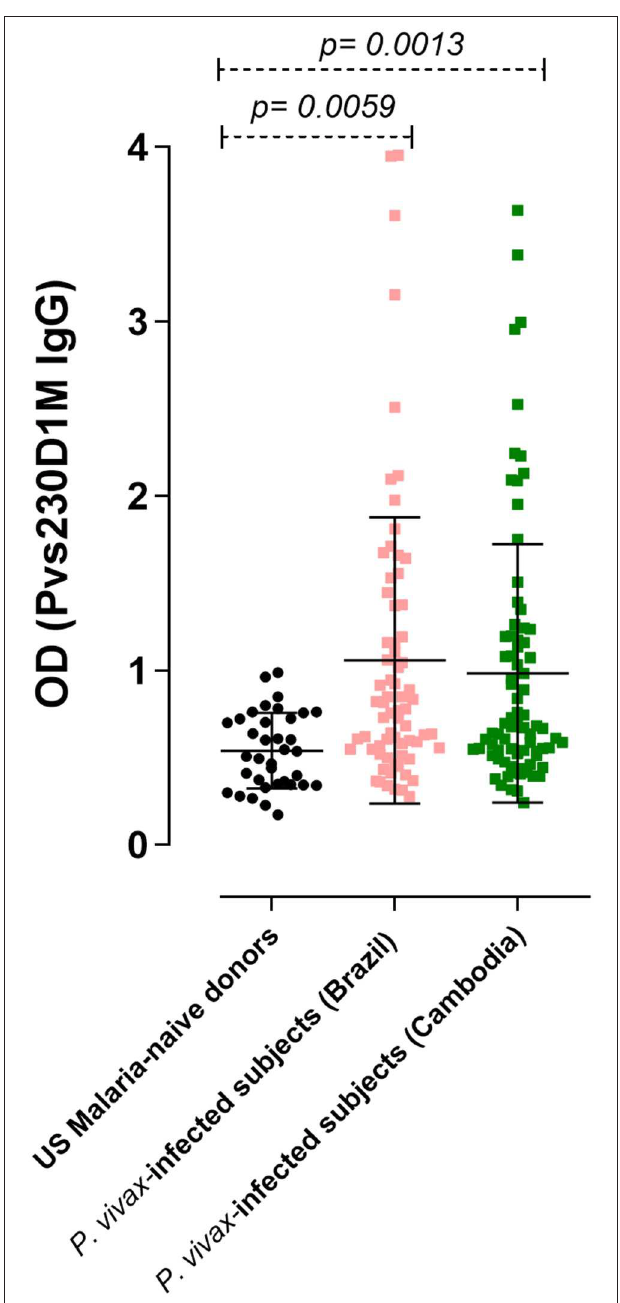
FIGURE 2 | IgG response against Pvs230D1M in P. vivax -infected subjects, determined by ELISA. The seroprevalence of antibodies with specificity for Pvs230D1M in Brazil was 27.1% (19/70 subjects), and in Cambodia 26.6% (21/79 subjects). Cut-off value (1.18) was calculated based on mean control + 3 standard deviations. One-Way ANOVA followed by multiple comparisons was used for this analysis and results are displayed as mean ± SD.